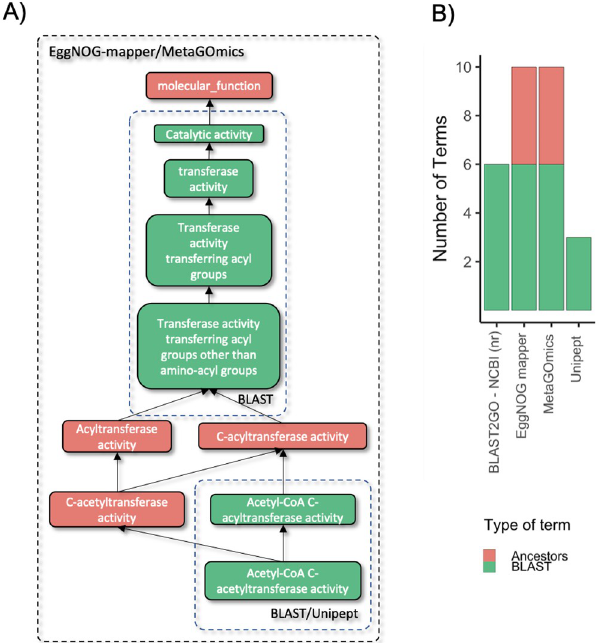
Fig 3. Analysis of peptides associated with acetyl-CoA C-acetyltransferase activity. A.) A combined GO hierarchy of unique terms annotated from a single peptide (sequence = FKDEIVPVVIPNK) for peptide-level tools (Unipept, MetaGOmics, and EggNOG-mapper), and a baseline tool: BLAST2GO—NCBI (nr). This peptide was selected from a group of 20 peptides randomly selected from all possible peptides that annotated ‘Acetyl-CoA C-acetyltransferase’ from the peptide-level tools. The peptide was selected since it shared results with the most number of peptides (10). Similar analyses for these other peptides are included in Supplement S5 in S1 File. In this hierarchy, an arrow indicates “is a” or parent/children relationships. Colored blocks represent GO terms (color represents relationship type). Dashed block outlines (non-colored) are labeled with tools that encapsulate GO terms that were annotated by that tool. B.) A stacked bar chart representation of the related terms (descendants, ancestors, or ancestor’s children). Colors correspond to these relation types. Green represents terms that were found through BLAST2GO’s annotation via NCBI (nr). The other colors represent the relationship of the other terms in other tools to those BLAST GO terms. These types are quantified and stacked on one another to show the contributions of each relationship type to the overall GO